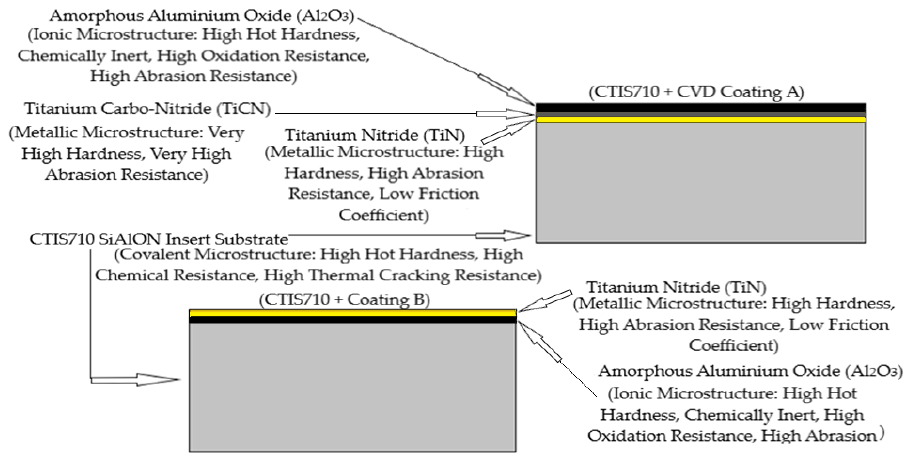
Figure 2. Cross-sectional view of the coating system’s microstructure and its mechanical character-